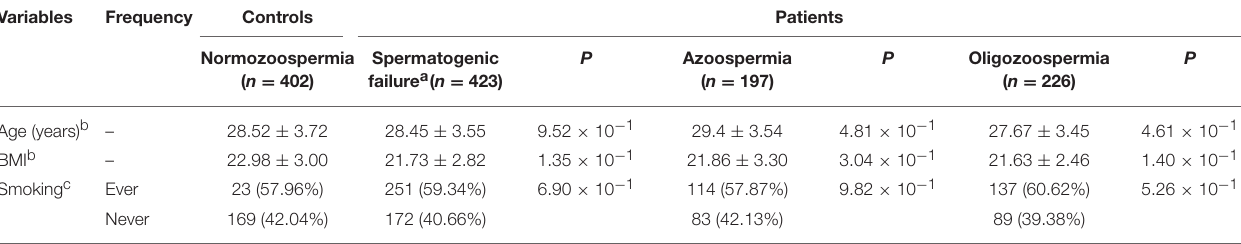
TABLE 1 | Study population information of controls and patients.